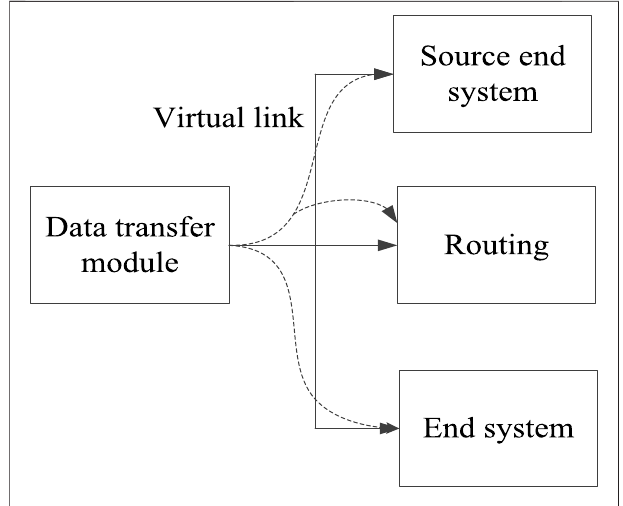
FIGURE 3 | Schematic diagram of data